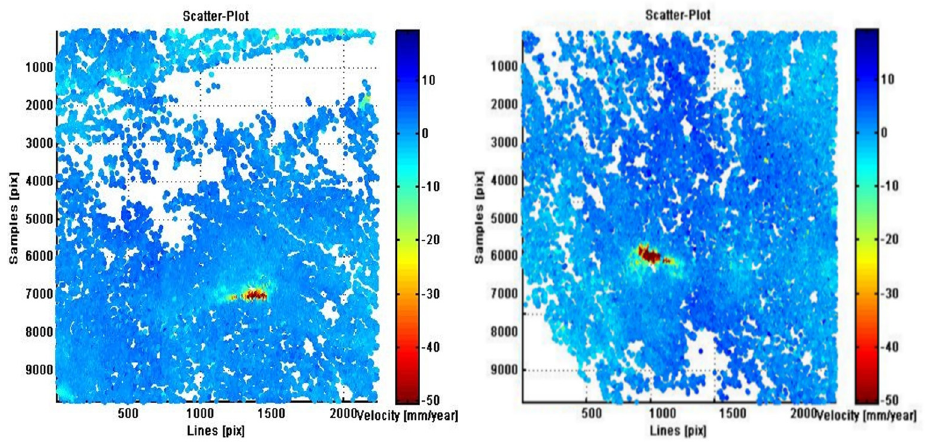
Figure 6. The scatter plot of Sentinel-1 data descending track on the right side and ascending on the left side (2017–2019). The subsidence map obtained from both descending (track number 107) and ascend- ing (track number 100) tracks during the time period of analyses showed sufficient PS points in the study area (Figure 7). The subsidence maps are superimposed over Google Earth in the study area. In the study area, a dense points cloud can be seen in Figure 7a,b; here, the results in both the ascending and descending tracks show that most of the area is stable (marked in blue), which are relatively upland or hilly terrains. While the main settlement areas along the main road are shown in red, highlighting the relatively high subsidence area. The color ramp (red = high, blue = stable, yellow/light green = low) rep- resenting movement and the relative stability of the PS points.